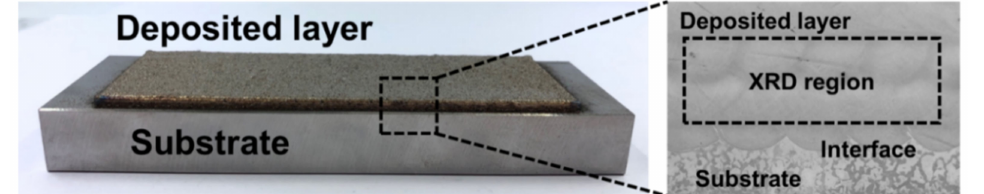
Figure 4. Cross section of deposited specimen for XRD analysis.